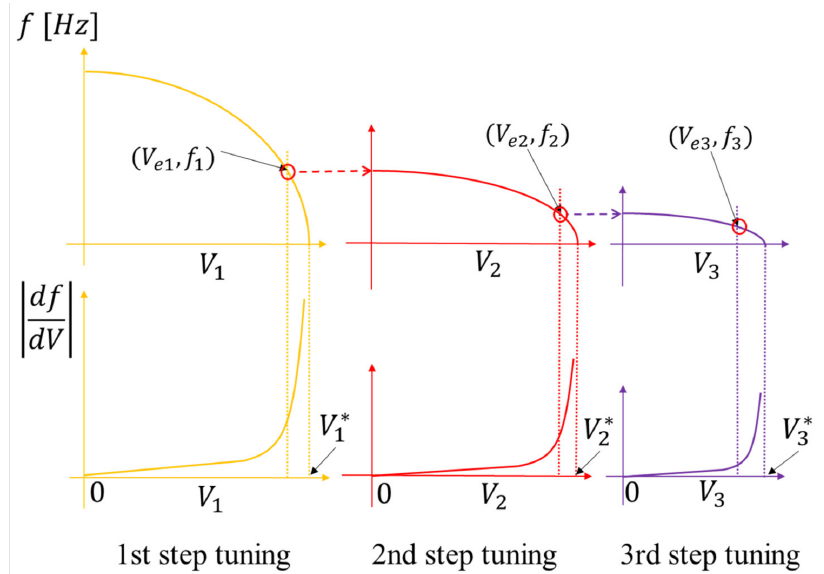
Figure 2. The basic principle of multi-step electrical tuning. In the 1st, 2nd, 3rd step tunings, frequencies will become 0 at V ∗